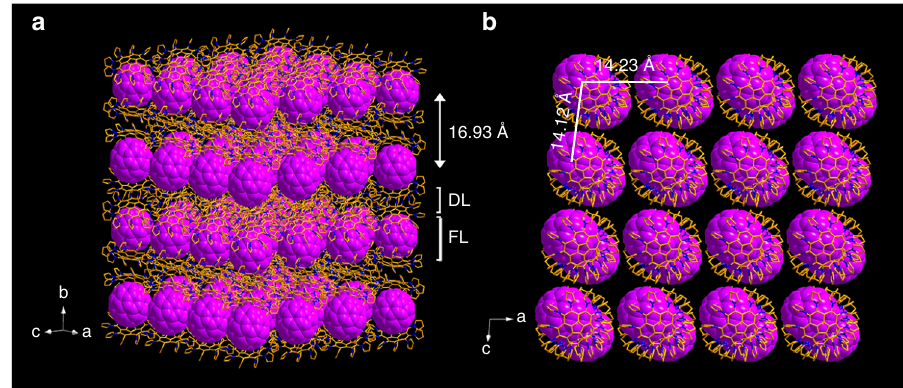
Fig. 5 Layered structure of the co-crystal formed between DPC ( 2a ) and C 60 . a , b Edge-on view ( a ) and top view ( b ) of the space- fi lling structure of C 60 and the stick structure of DPC. FL is a monolayer of C 60 , and DL is a slightly corrugated double DPC layer. C atom is shown in gold, N atom in navy blue, and C 60 in purple. All hydrogens and solvent molecules (CS 2 ) in the co-crystal have been omitted for